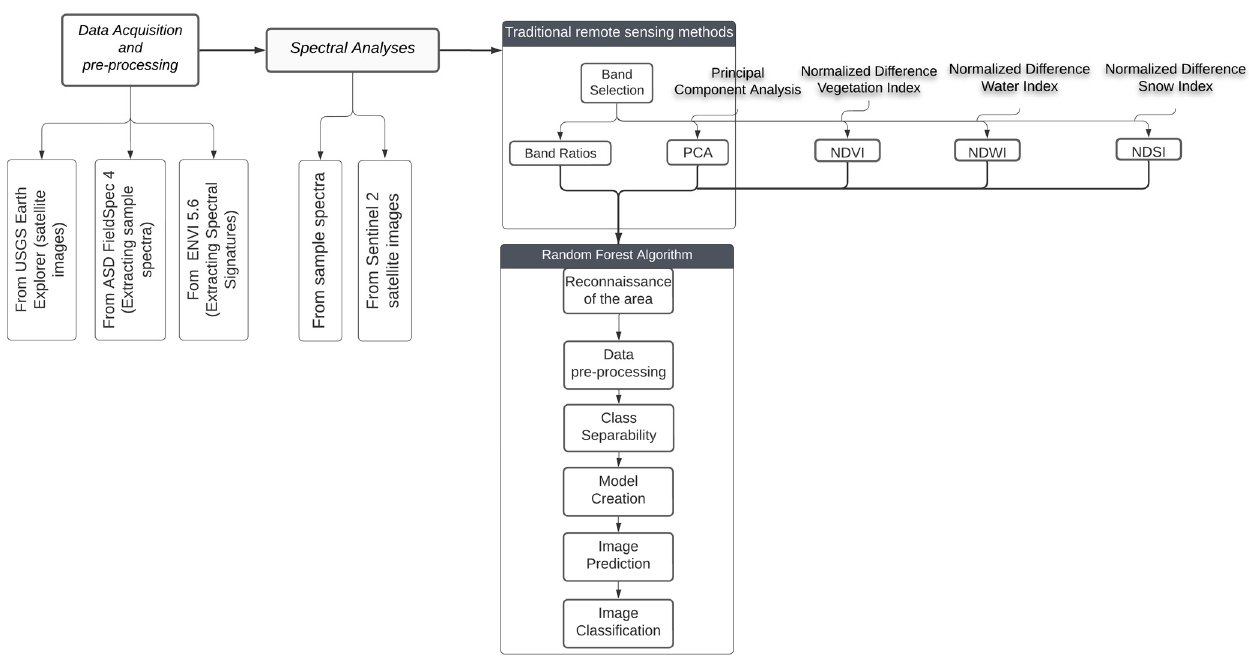
Figure 3. Workflow of the applied methodology to select and adapt the traditional remote sensing methods.